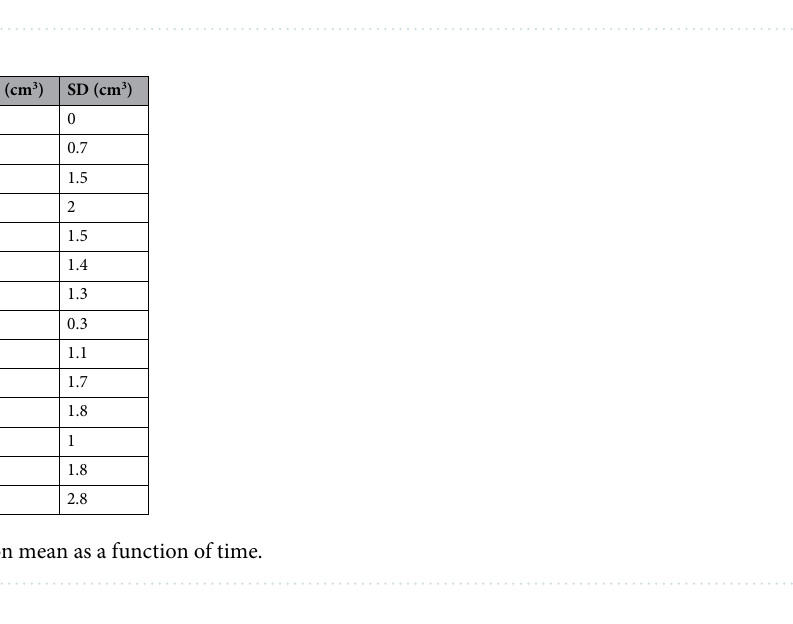
zone, but also in the lesion center. GFAP staining showed astrogliosis in the surrounding brain parenchyma and in the periphery of the lesion (Fig. 3). We used the contralateral side of the brain as a control, see Supplementary Fig. 1. MRI. The MRI scans showed expected postoperative changes following the frontoparietal burr hole to the right of the midline, with discrete thickening and increased contrast enhancement in the dura underlying the burr hole. Cranial to the right lateral ventricle was (as intended) a large, well-defined lesion that was hyperintense and slightly inhomogeneous on the FLAIR sequence with a discrete hypointense ring; isointense to white matter